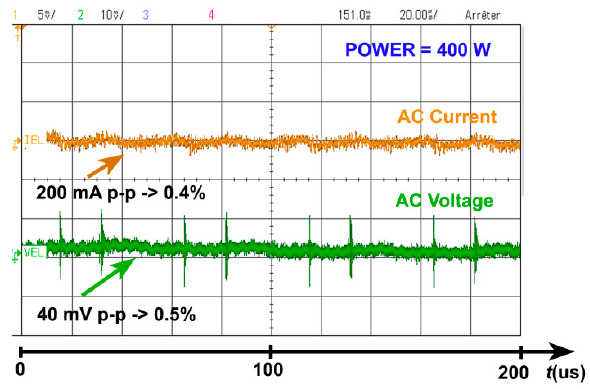
Figure 15. AC component of the voltage and current at the terminals of the electrolyzer with rated power.